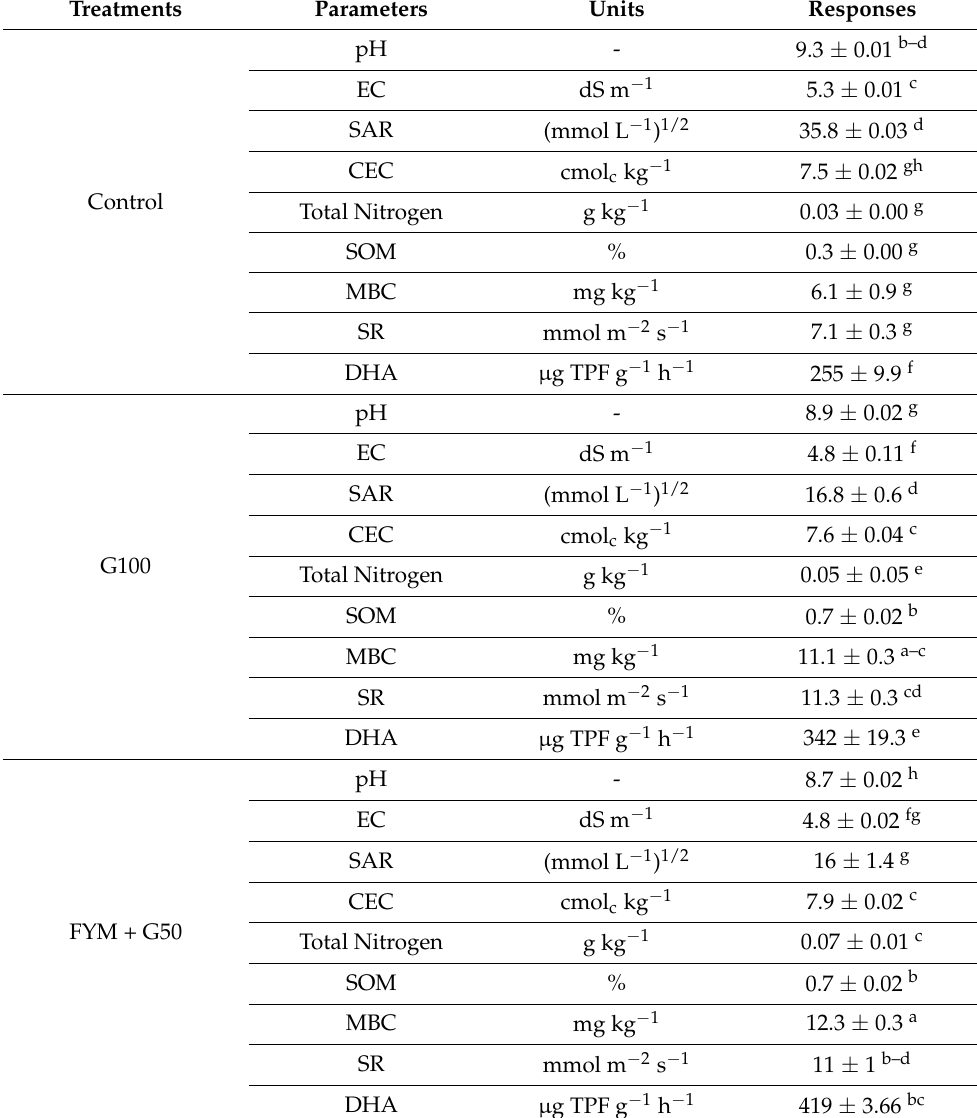
Table 2. Variation in the soil’s physico-chemical properties after different treatments in the fallow period. Rounded-off values after ± represents standard error ( n = 3). Different letters indicate statistical difference (LSD, p <